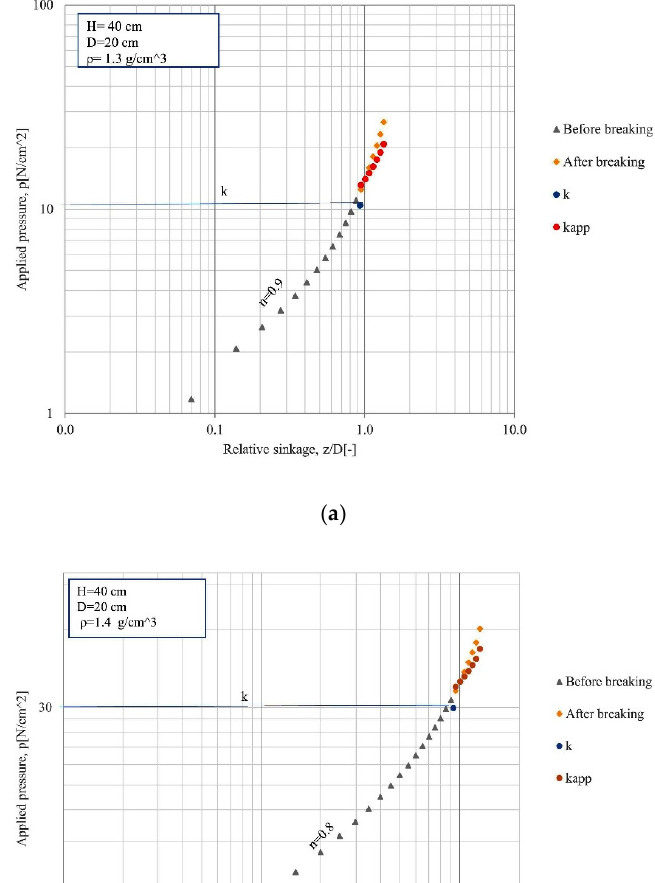
Figure 8. Pressure–sinkage curves with k app for a soil thickness level of 30 cm at bulk densities of ( a )